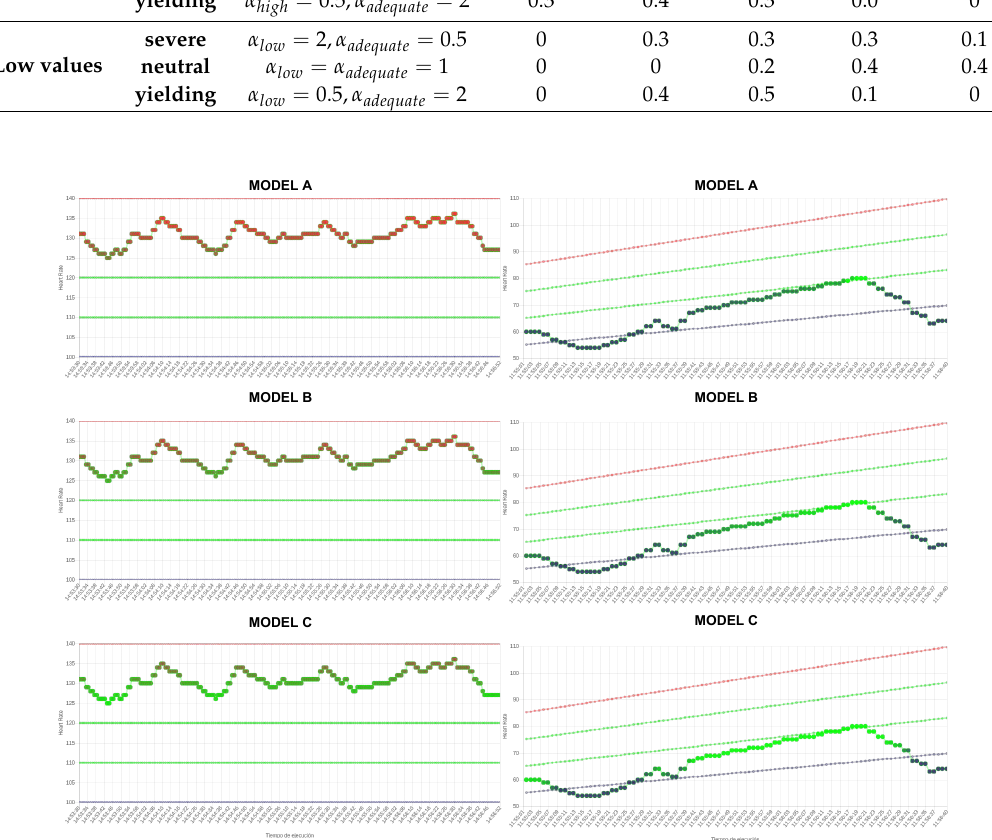
Figure 5. Impact of the fuzzy modifiers on heart rate streams. Heart rate is plotted using gradually changing colors blue, green, red based on the degree of the terms { low , adequate , high } , respectively. Green dotted lines determine the OHRTZs of patient. Blue and red dotted lines determine aerobic thresholds VT 1 , VT 2 of the patient, respectively. The impact of the models A, B and C for a case of high–adequate HRs ( right ); and the impact of the models A, B, and C for a case of low–adequate HRs ( left